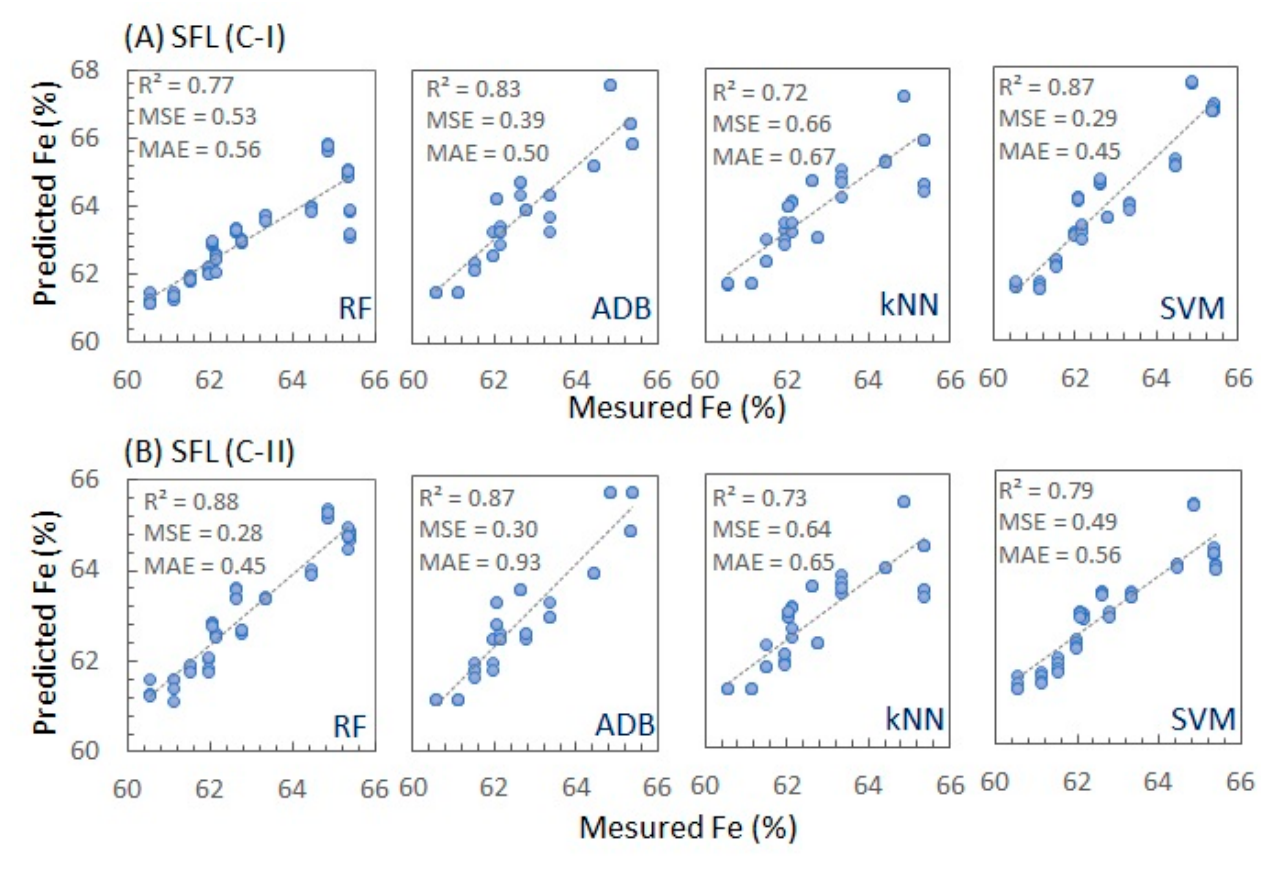
Figure 8. ( A , B ) Results of the models for the estimation of Fe tested with the Sinter Feed samples prepared in the laboratory with the C-I and C-II spectra, respectively. The graphs show good alignment of the samples for RF, ADB and SVM. For kNN, the samples are more dispersed.